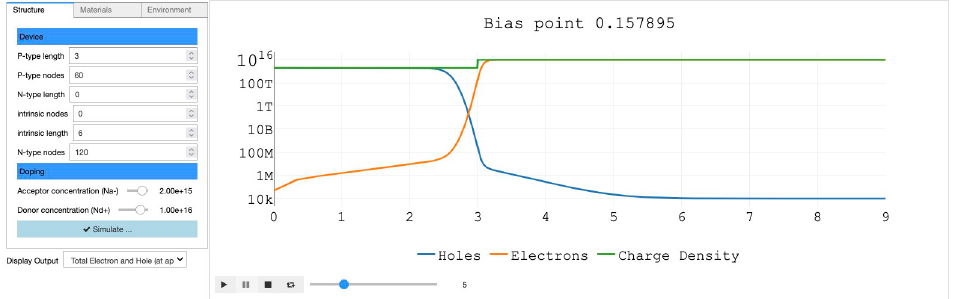
Fig 5. P-N junction App invoked a Sim2L that performs the device simulations. The App enables users to easily setup the simulation and visualize results. The example shows the charge density of the diode for an applied voltage of 0.157895 eV, the slider allows user to visualize different applied